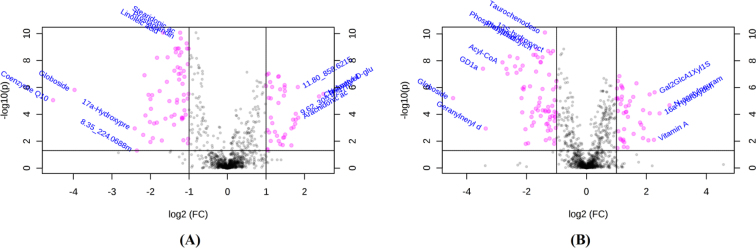
Volcano plots for the potential metabolomic features of muscle samples from female (A) and male (B)C. idellus (n = 10). Pink points indicate significant metabolites between the two groups (FC <0.5 or >2.0; qvalue <0.05). The gray points show tentatively matched features with no significance. The potential biomarkers between experimental groups were annotated with their matched metabolite names; those nonannotated peaks were marked with their corresponding mass weights and retention time.